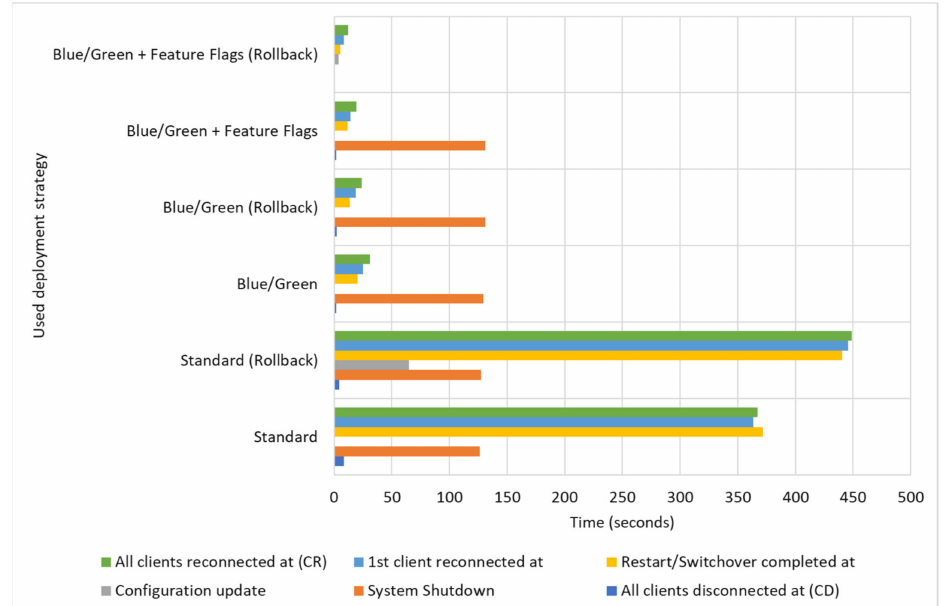
Figure 12. Comparison of time needed for various stages of the update process using standard, blue/green, and blue/green with feature flags